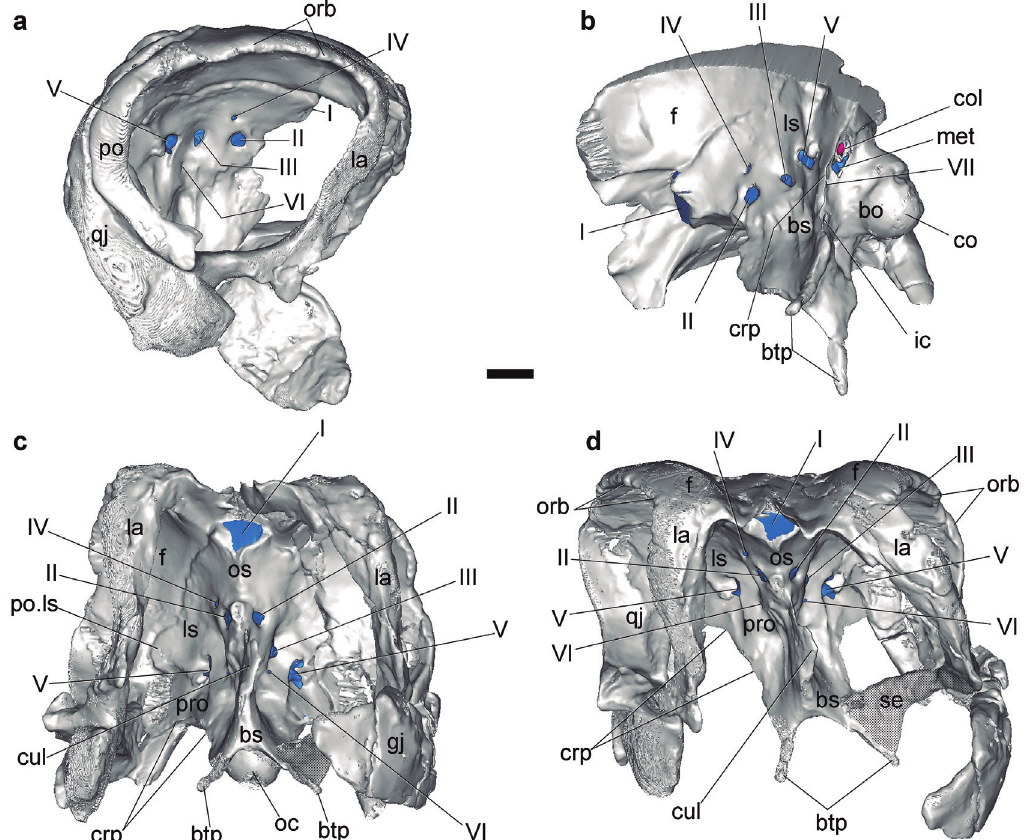
Figure 1. Segmentation of the braincase and articulated skull bones of Limaysaurus tessonei (MUCPv-205) in a, right lateral; b, left lateroventral; c, ventral and d, anterior views. In b, lacrimal, postorbital and the margin of the orbital rim formed by the frontal were longitudinally sectioned and removed to allow better observation of the lateral wall of the braincase. Abbreviations: bo, basioccipital; bs, basisphenoid; bt, basal tuber; btp, basipterygoid process; col, columellar recess; crp, crista prootica; cul, cultriform process; f, frontal; ic, cerebral branch of internal carotid artery; la, lacrimal; met, metotic foramen for CNs IX-XI; oc, occipital condyle; orb, orbital rim; os, orbitosphenoid; p, parietal; po, postorbital; po.ls, postorbital process of laterosphenid; pro, prootic; gj, quadratojugal; se, sediment attached to bone; I-VII, cranial nerves. Scale bar= 10